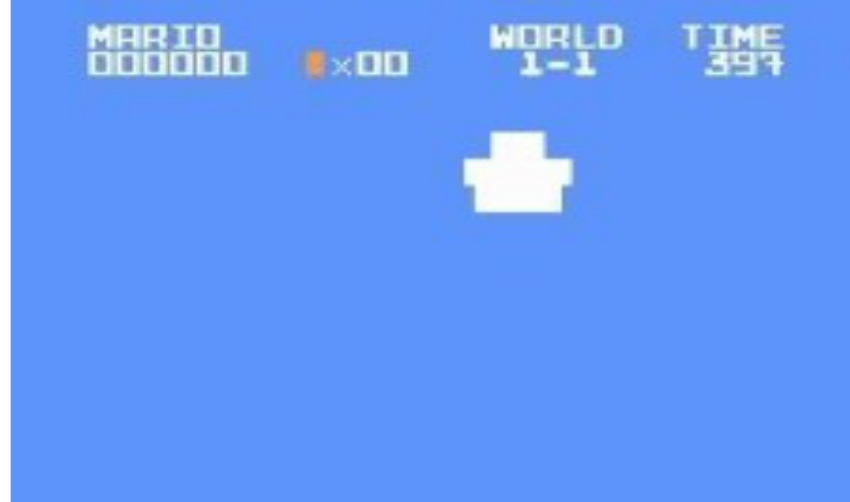
Figure 6. A visual of the initial state returned by the custom